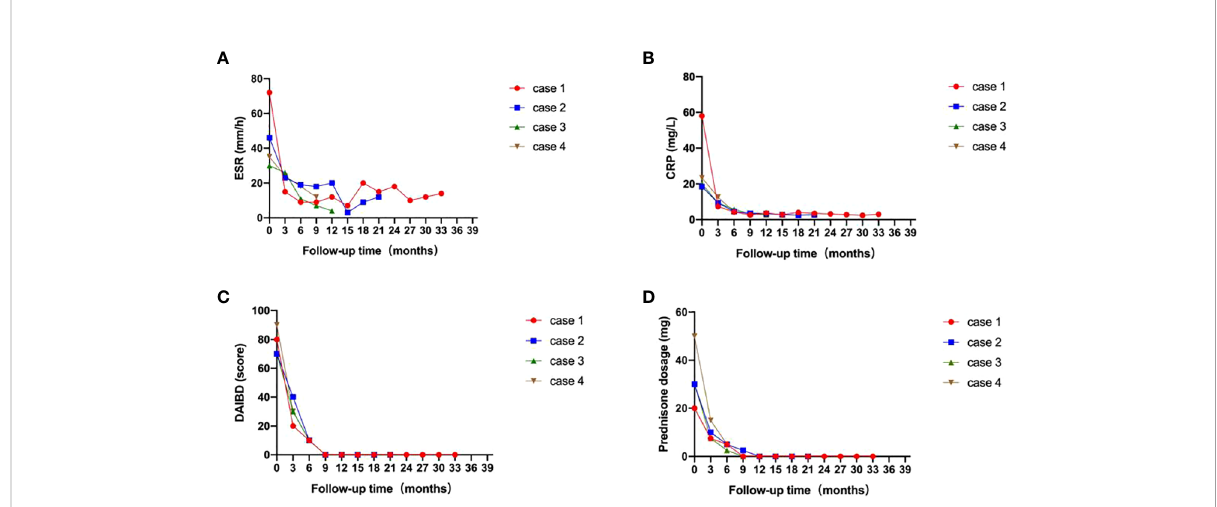
FIGURE 2 Ef fi cacy of tofacitinib for patients with intestinal Behc ̧ et ’ s syndrome (red: case 1; blue: case 2; green: case 3; brown: case 4). (A) Changes in erythrocyte sedimentation rate (ESR); (B) Changes in C-reactive protein (CRP); (C) Changes in disease activity index of intestinal Behc ̧ et ’ s disease (DAIBD); (D) Changes in prednisone dosage, during tofacitinib